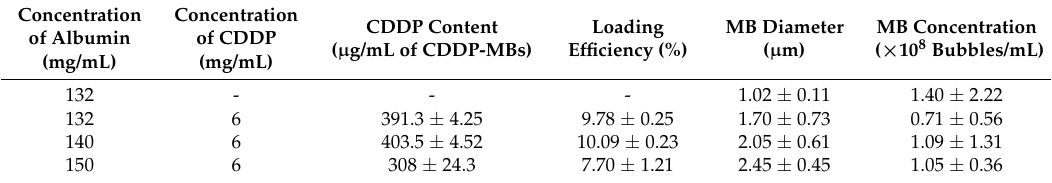
Table 1. Composition, diameter, number, and CDDP loading efficiency of CDDP-loaded albumin